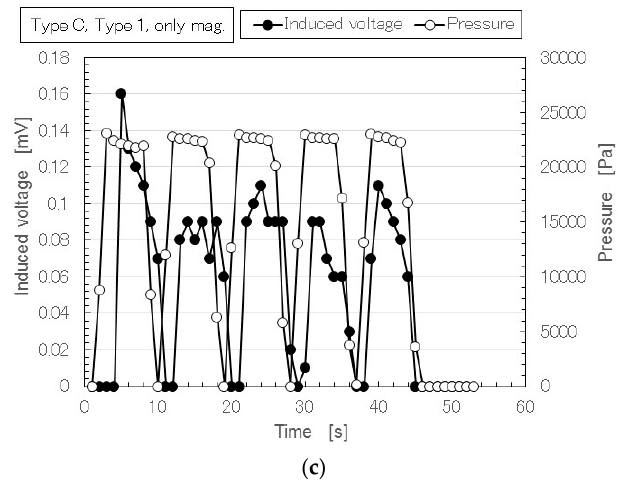
Figure 8. The results of time-lapse of the induced voltage and the pressure on MCF rubber created with the drying method only. ( a ) Type A; ( b ) Type B; ( c ) Type C.